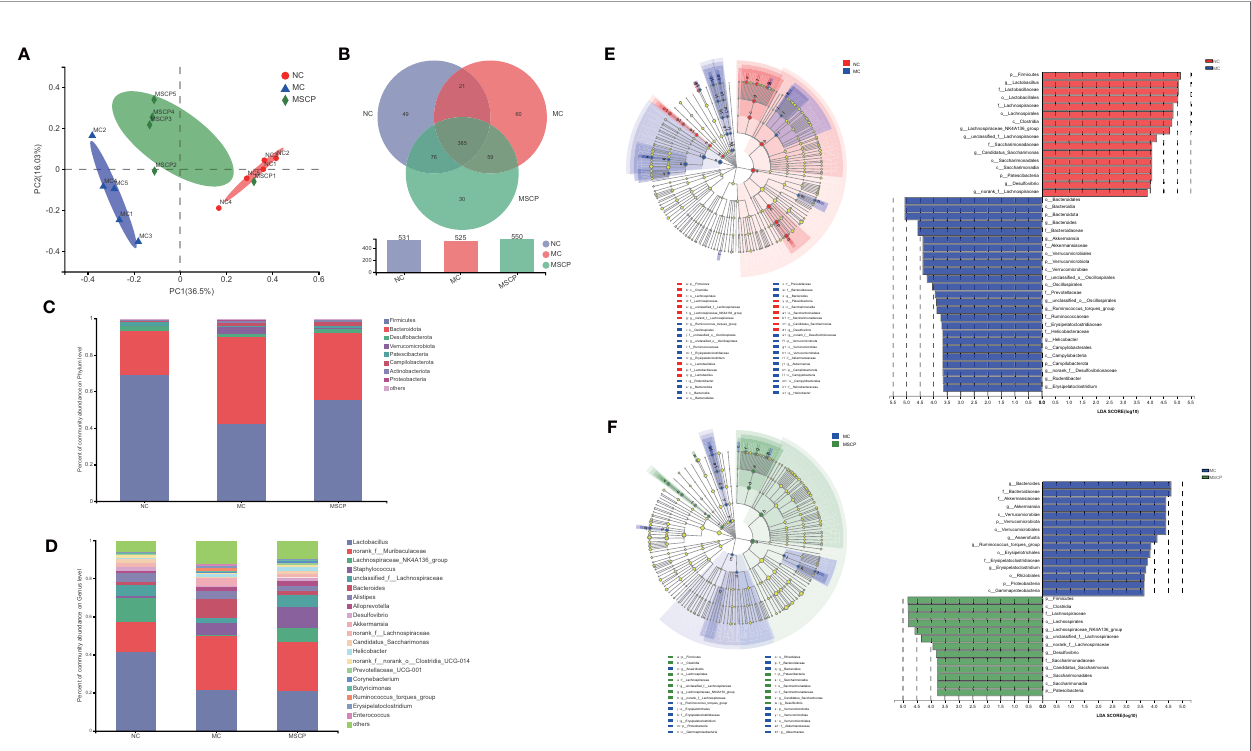
FIGURE 10 | MSCP treatments attenuated gut dysbiosis in CTX-induced mice. (A) Principal coordinate analysis (PCoA) of gut microbiota based on bray_curtis distance. (B) Similarity and difference of bacteria compositions in different experimental groups at the OTU level. (C) Relative abundance of microbiota at the phylum level. (D) Relative abundance of microbiota at the genus level. (E, F) Difference in dominant microorganisms among each group via cladogram and distribution histogram based on LDA. The greater the LDA score was, the more signi fi cant the phylotype microbiota was in the comparison. (E) NC group and MC group. (F) MC group and MSCP group. (A – F) Data are pooled in one independent experiment.